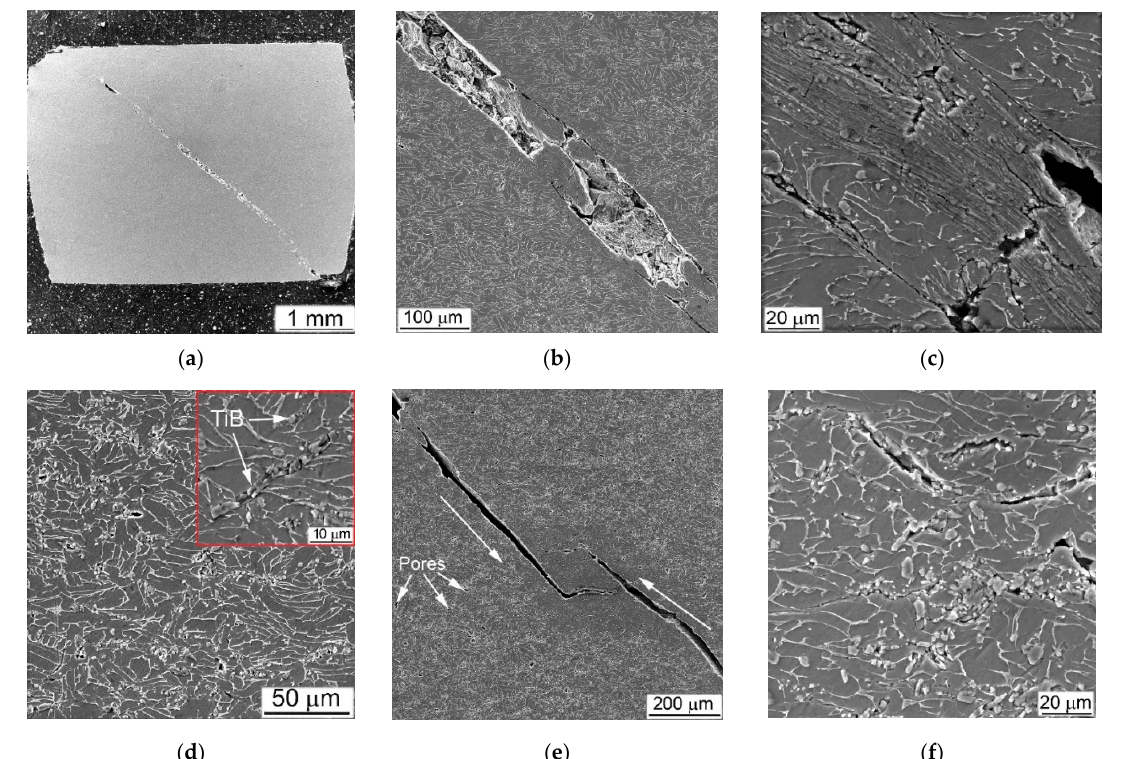
Figure 19. SEM images of ( a – d ) Ti64BEPM + 5TiB, and ( e , f ) Ti64BEPM + 10TiB after QSC tested with the rate 10 − 3 s − 1 . ( a ) General view of the specimen, ( b , c , e ) Zone II, ( d , f ) Zone III. SEM, ( a ) SE, ( b – f ) BSE. Large arrows in ( e ) indicate the shift direction of the sample’s halves.